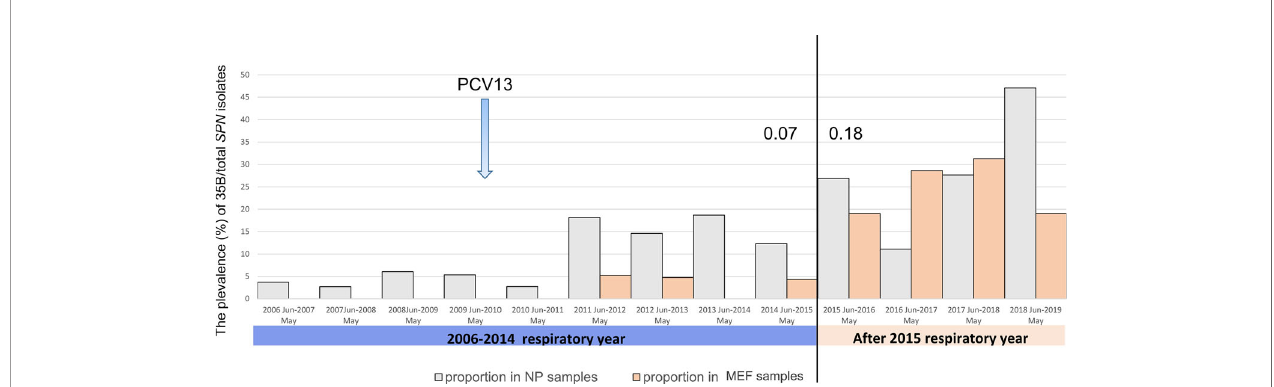
Figure 1 . Before introduction of PCV13 in 2010, serotype 35B was rarely isolated. After 2011, the relative prevalence of colonizing serotype35Bstrains(fromhealthyNP)signi fi cantlyincreasedfrom 2.7 to 6.1% of all SPN (from June 2006 to May 2011) to 12.3 – 18.8% (from June 2011 to May 2015). Despite colonization prevalence, AOM infections were infrequent. Beginning from June 2015, the prevalence of 35B increased, and it became the most frequently isolated serotype from MEF during AOM bouts. To see the risk of AOM given the frequency of colonization, we calculated the case- to-colonization ratio changes among 35B isolates over time and found AOM cases (MEF isolates during AOM) as a proportion of controls (NP isolates from healthy colonization) signi fi cantly increased from 0.08 for the period before June 2015 to 1.68 for the period after May 2015 (p=0.002). Thus, introduction of PCV13 in 2010 was followed by increased prevalence of NP colonization with serotype 35B strains, and an additional shift to higher prevalence and increased AOM disease burden beginning in 2015. Belong to a Single Clonal Complex but Capsular Switching Also Occurred Among 163 35B strains tested, 13 distinct sequence types (STs), including two newly identi fi ed STs were identi fi ed ( Figure 2A ). Most 35B strains belonged to ST558 (89% of pre-2015 and 70% of post-2015 isolates). Although ST558 isolates were detected at comparable levels in healthy children among pre-2015 and post- 2015 isolates(6.0 and 5.6%), their isolation among children causing AOM signi fi cantly increased post-2015. When the ratio of AOM disease cases to healthy colonization was calculated only among ST558, values for pre-2015 and post-2015 were 0.09 and 2.18, respectively (p=0.0002), underlining the emergent AOM disease burden caused by ST558 SPN